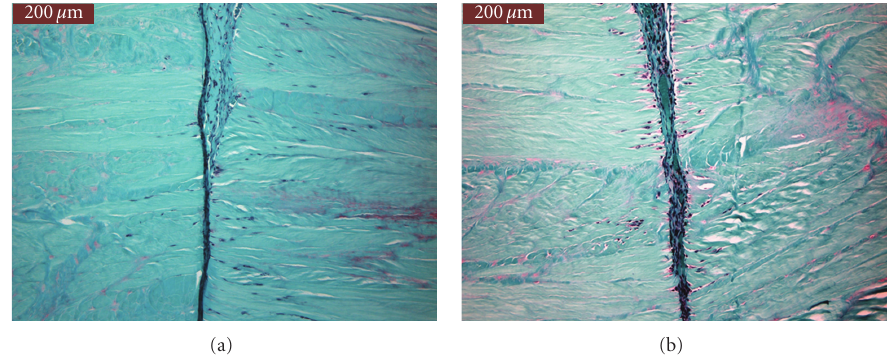
Figure 4: (a) and (b) show SOFG-stained sections with little positive SOFG-stain uptake. There was no significant di ff erences between the SOFG staining between groups. Cellular repopulation along the cut edge is evident in both